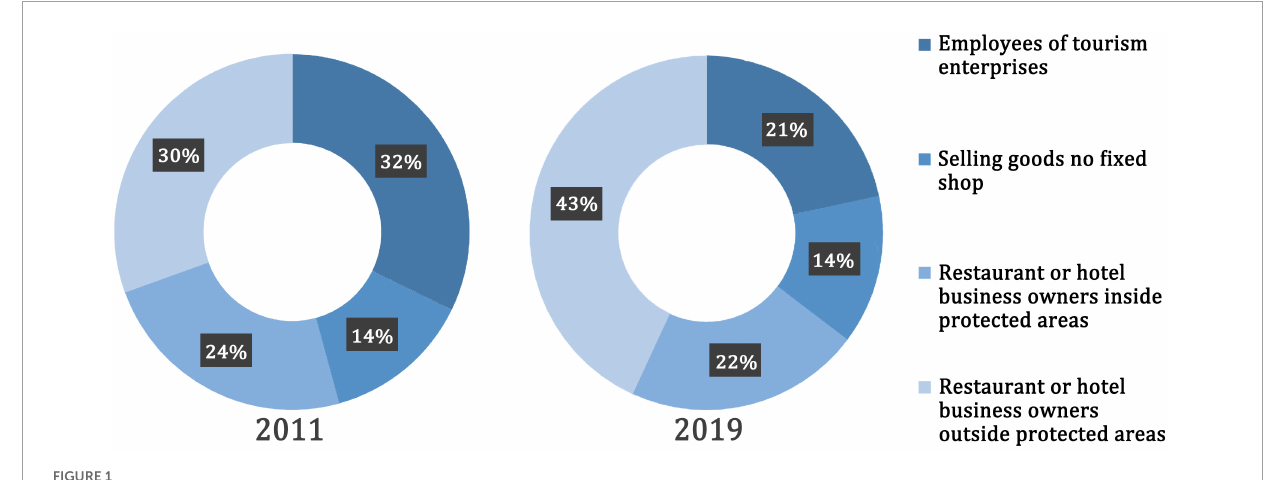
FIGURE1 Types of tourism